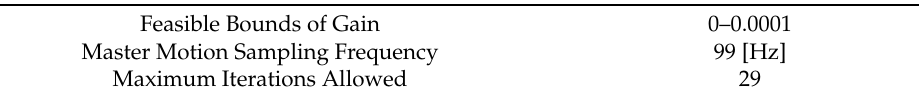
Table 2. Optimization